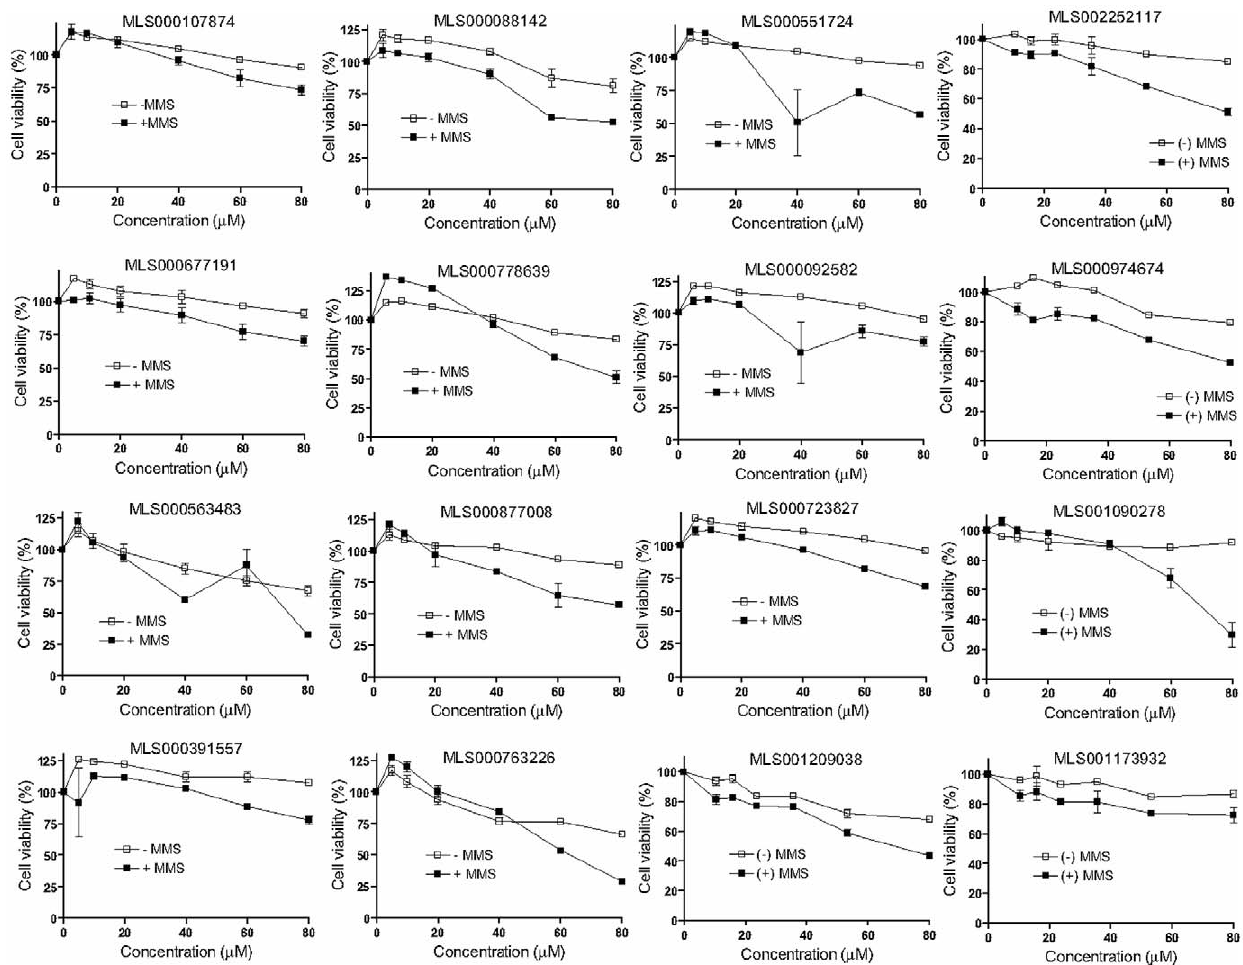
Figure 6. Modest potentiation of the genotoxic effect of MMS exhibited by 16 prioritized hits (designated I in Table S1). HeLa cells were exposed to a dilution series of each compound shown in the absence (empty squares) and presence of 400 m M MMS (filled squares), and after a 24-hour incubation the cell viability was measured by ATP-content detection using CellTiter Glo. Results are presented as averages and standard deviations from duplicate samples, normalized against vehicle